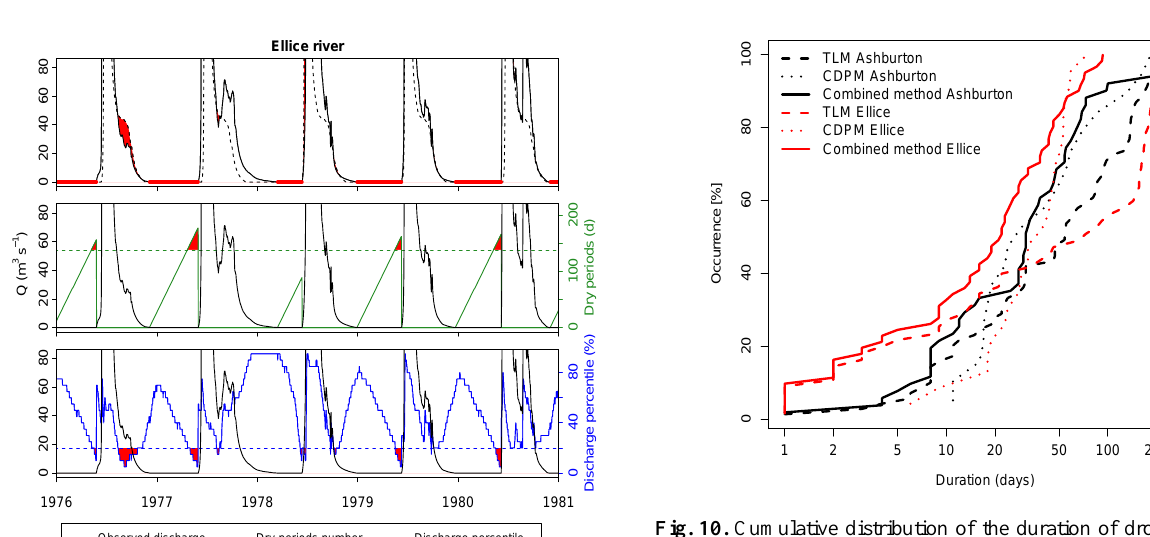
Fig. 10. Cumulative distribution of the duration of drought events determined with all three methods for Ellice River (red) and Ash- burton River (black). Dashed lines give the drought durations de- termined with the TLM. Dotted lines show the durations from the CDPM, and the solid lines are durations calculated with the com- bined